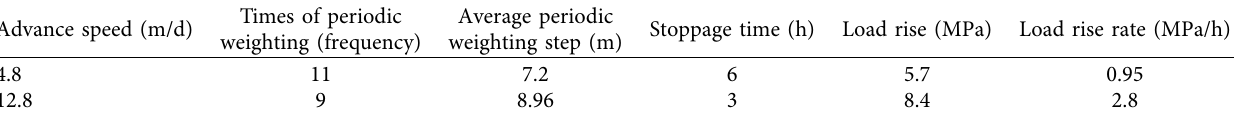
Figure 2: Load distribution on the support at different rates of advance. (a) Load distribution on the working face support when the rate of advance is 4.8m/d. (b) Load distribution on the working face support when the rate of advance is 12.8m/d. Table 3: Measured pressure